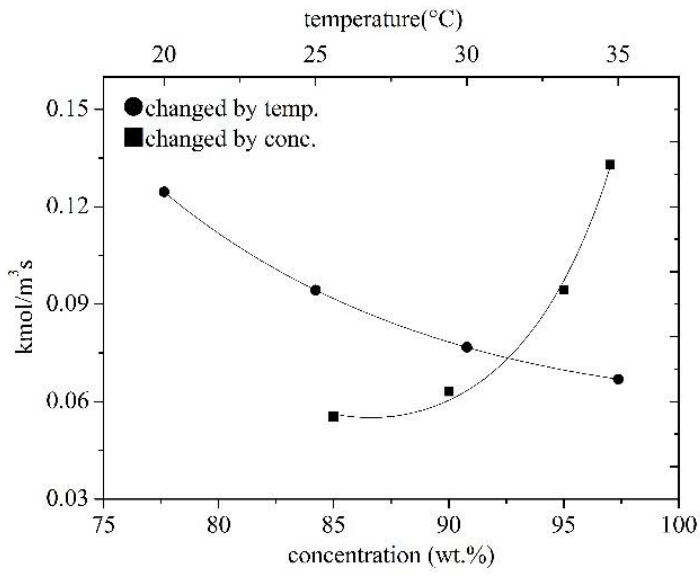
Figure 6. Effects of concentration and temperature of the TEG solution on mass transfer coeffi- cient.